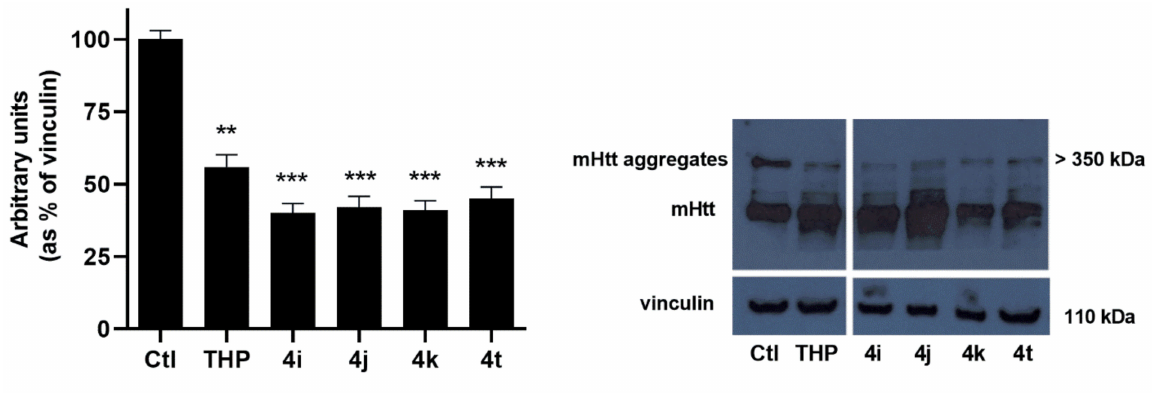
Figure 5. Representative western blot of mHtt aggregates in the STHdh Q111 / 111 cell line incubated for 72 h in the presence of of 50 µ M 4i , 4j , 4k , or 4t . Densitometric quantification was performed on three di ff erent experiments, and the results are expressed as the mean of the values obtained (mean ± SD). ** p < 0.01 and *** p < 0.001 versus